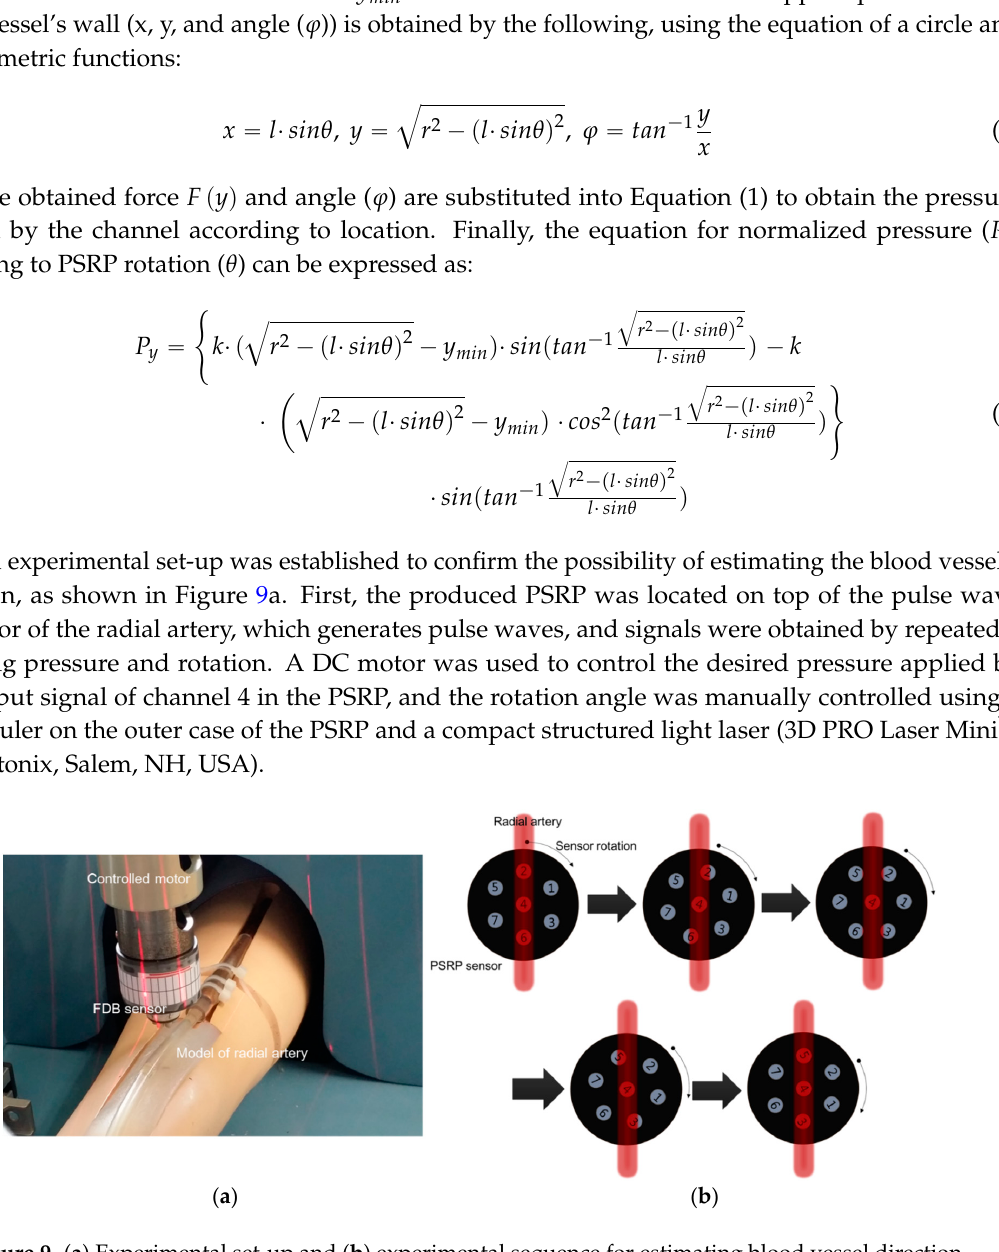
signals were only received from channel four and signals from other channels were absent. The